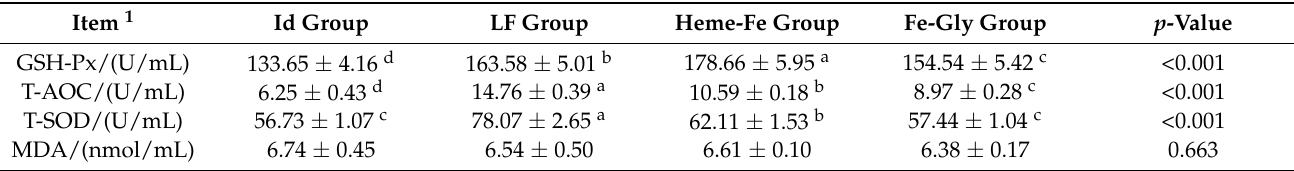
Table 6. Effects of iron sources on serum antioxidant indices in sows.